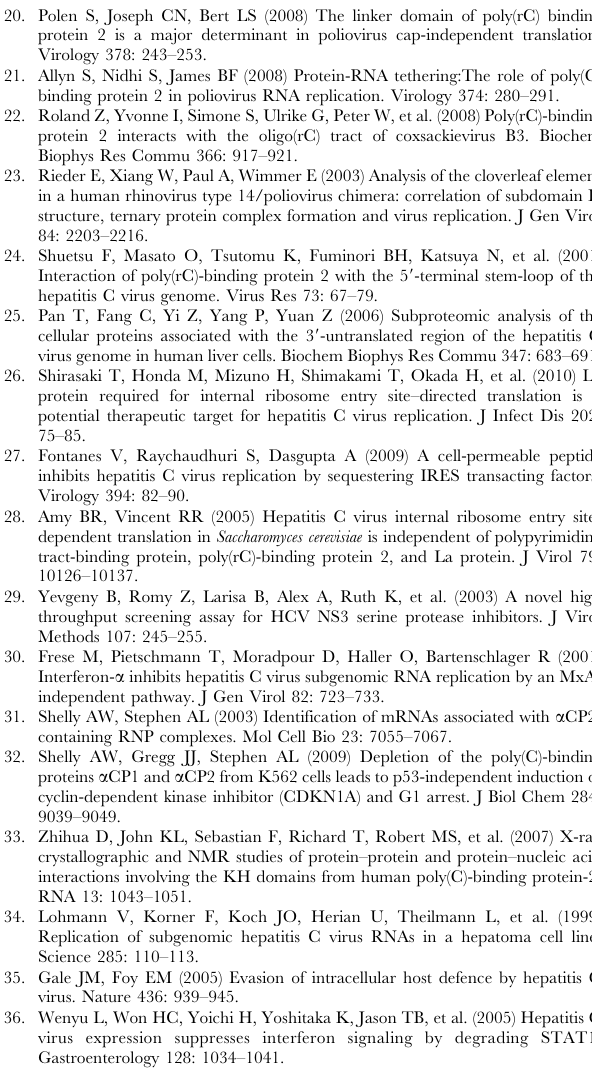
Table S1 RIP-qRT-PCR Primers. The primer sets of mRNAs detected in qRT-PCR assay are listed in the